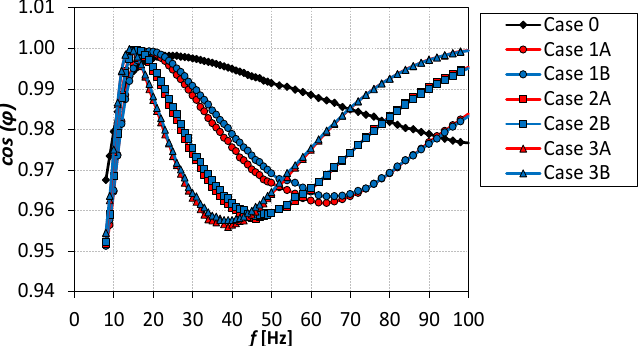
Figure 4. The power factor as a function of frequency at p = 3 W.